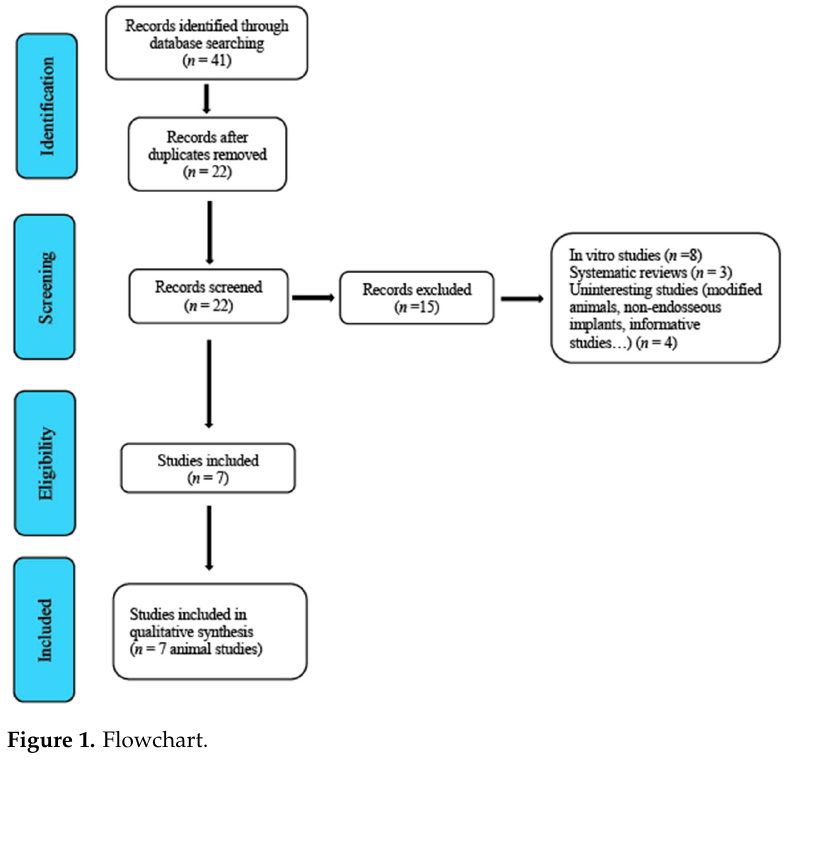
Figure 1. Figure 1. Flowchart. Table 2. Characteristics of included studies.